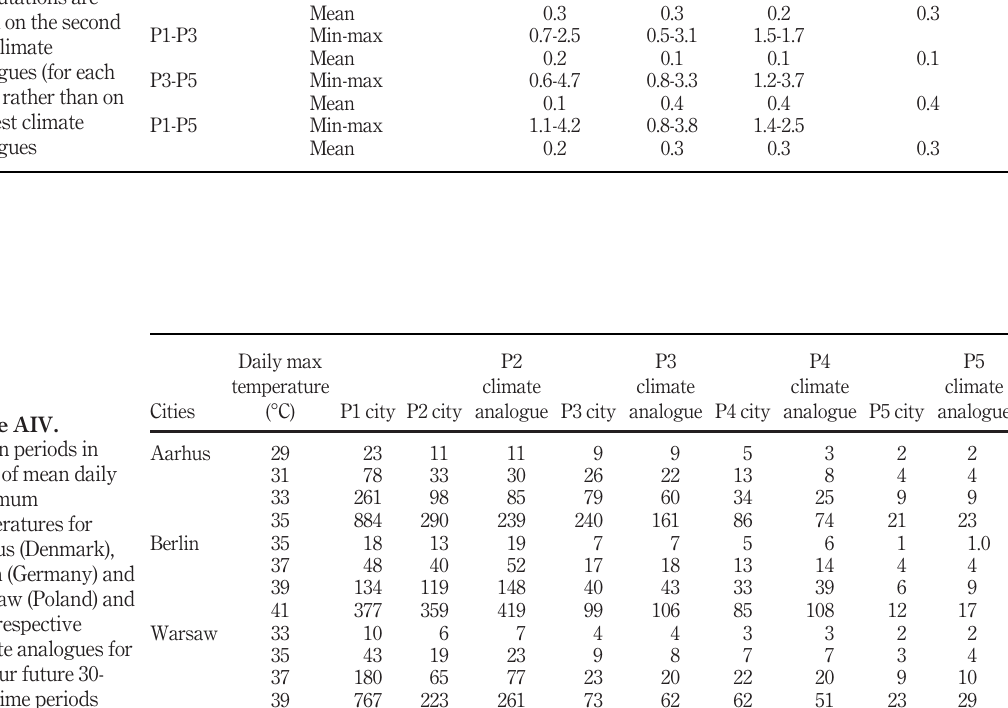
Table AIII. Sensitivity analysis showing the absolute difference of minimum, maximum and mean southward climate shift velocity (for the three transects and the seven shift time periods) when computations are based on the second best climate analogues (for each LOIs) rather than on